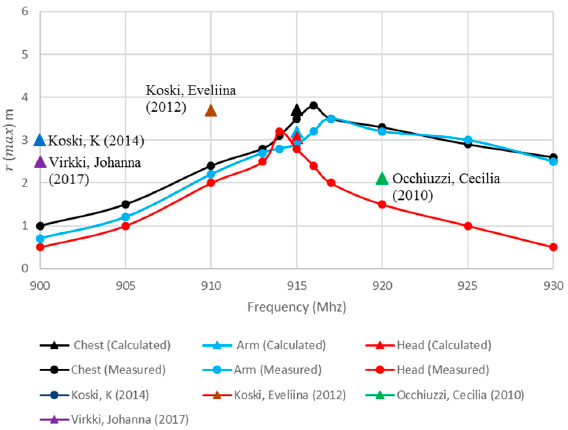
Figure 10. Measured and calculated read range when the tag antenna is fixed at various body locations compared to earlier studies.